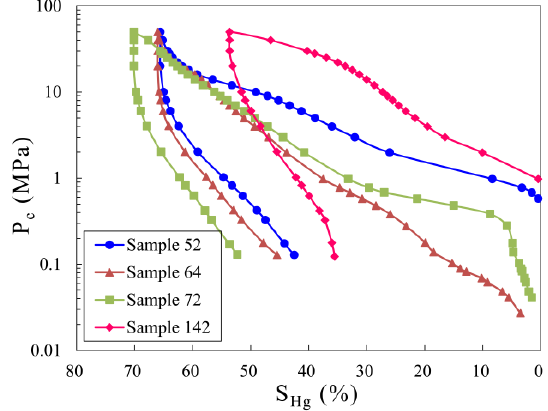
Figure 1. Four typical mercury intrusion curves.